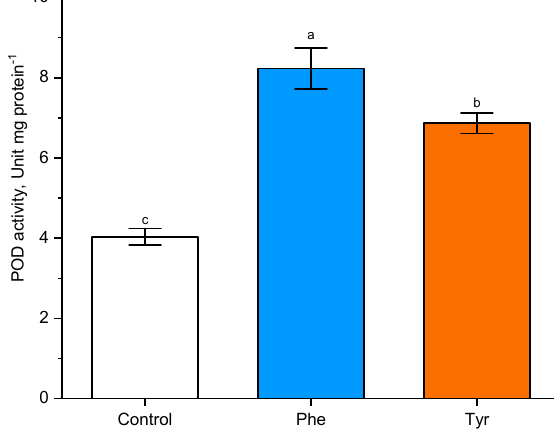
Figure 6. E ff ects of phenylalanine and tyrosine on POD activity. Bars marked with di ff erent letters Figure 6. Effects of phenylalanine and tyrosine on POD activity. Bars marked with different letters show significant di ff erences at ( p ≤ 0.05) according to Tukey’s show significant differences at ( p ≤ 0.05) according to Tukey’s test.